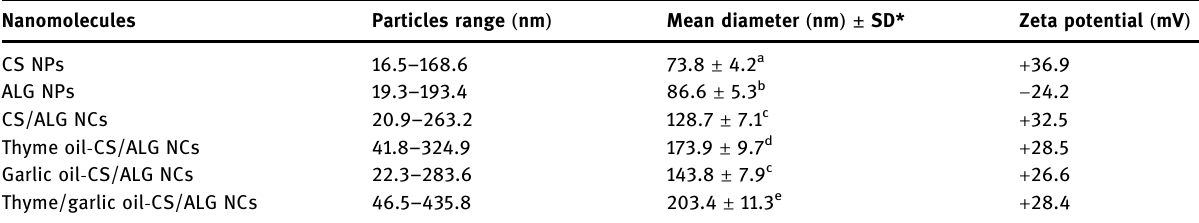
Table 1: Particles size distribution and charges ( zeta potential ) of synthesized nanoparticles and NC Nanomolecules